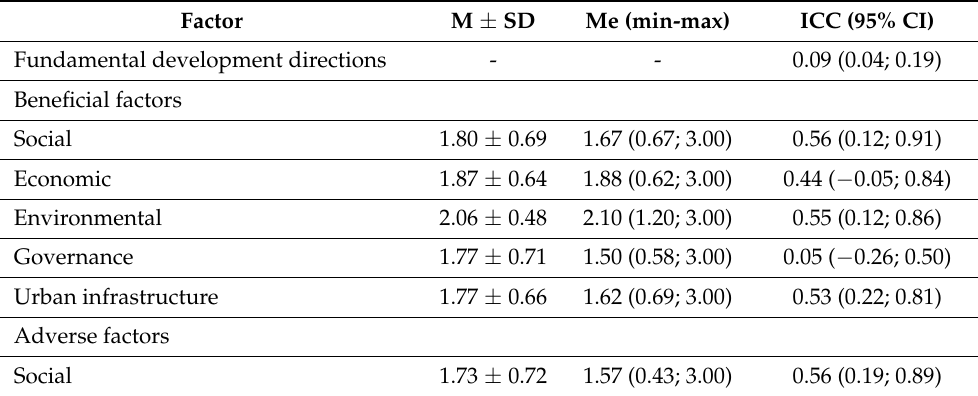
Table 10. Characteristics of beneficial and adverse factors (general indicators) and ICC analysis for all factors studied (own